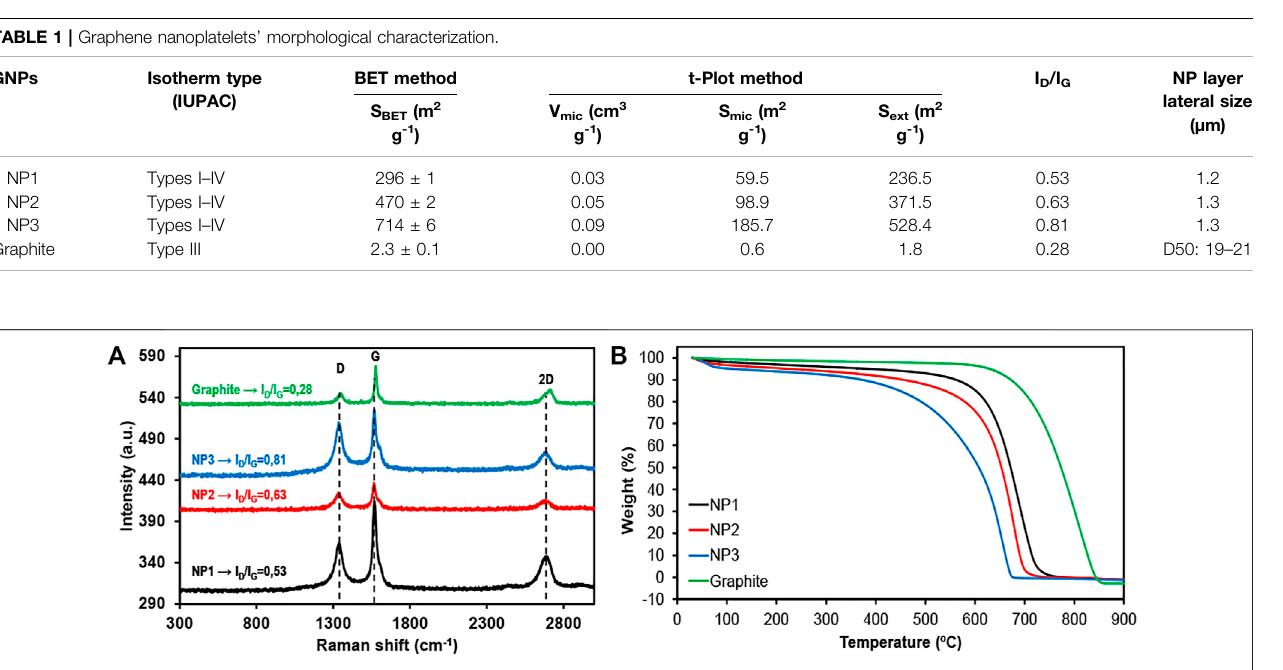
FIGURE3|(A) Ramanspectraofgraphiteandthreegraphenenanoplateletsrecordedusinga514 nmexcitationlaser.Thespectraexhibitthe2D,G,andDbands at about 2,750, 1,590, and 1,350 cm − 1 , respectively. (B) TGA decomposition pro fi le in air at 10 K min − 1